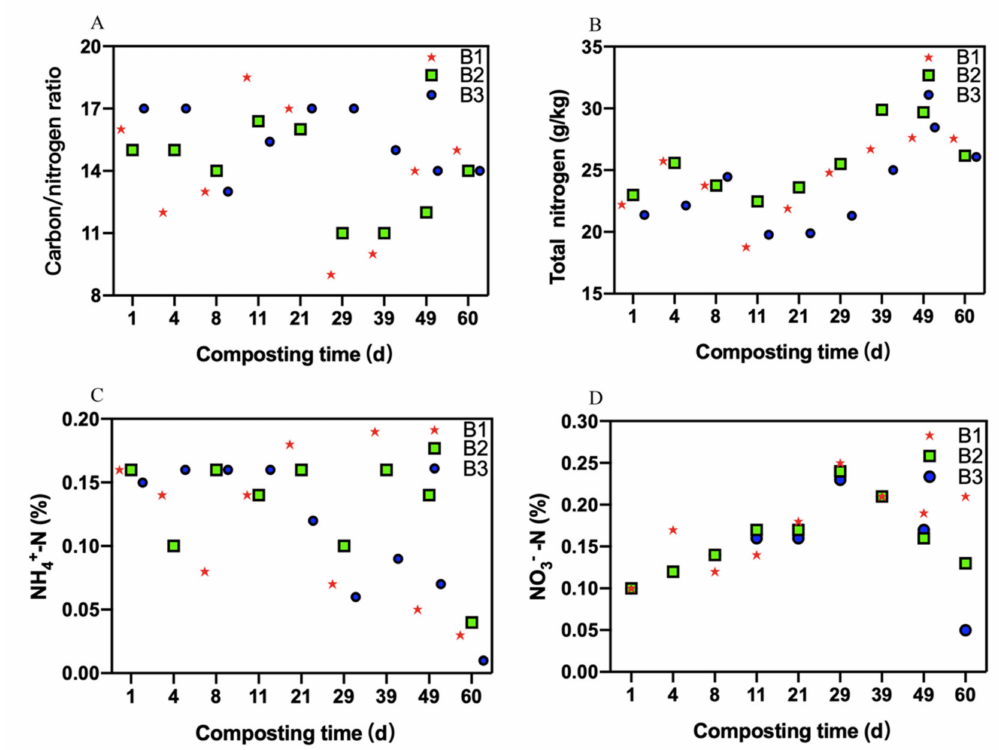
Figure 2. Variation in the contents of nitrogen components. ( A ): Variation in the carbon/nitrogen ratio (C/N); ( B ): Variation in the total nitrogen (TN) content; ( C ): Variation in the NH 4+ -N percentage; ( D ): Variation in the NO 3 − -N